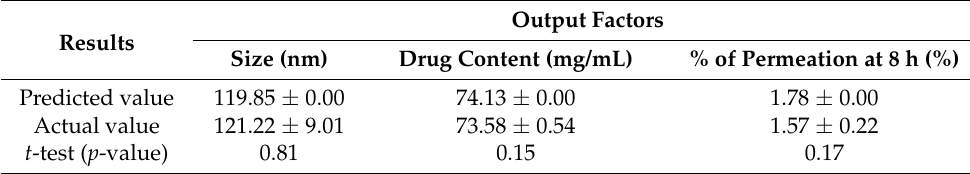
Table 3. Predicted value and actual value of output factors from optimized FLUZ-loaded MEs